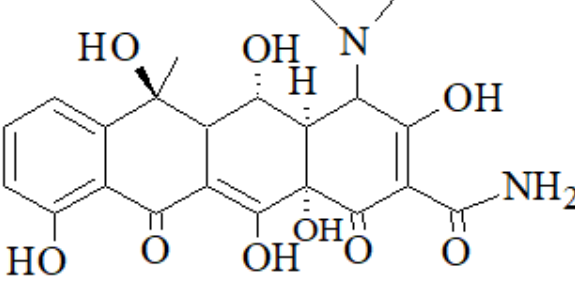
Figure 2. The structure formula of OTC.